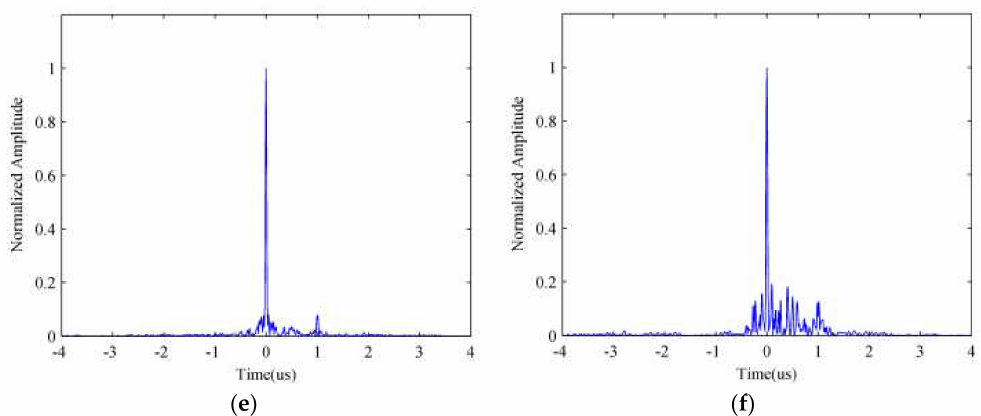
Figure 12. Simulation results of Approach I under different JSR conditions. ( a ) The compression result of the received signal with JSR = 10 dB; ( b ) the compression result of the received signal with JSR = 20 dB; ( c ) the band pass filtering function in the time domain with JSR = 10 dB; ( d ) the band pass filtering function in the time domain with JSR = 20 dB; ( e ) the suppression result with JSR = 10 dB; ( f ) the suppression result with JSR = 20 dB.